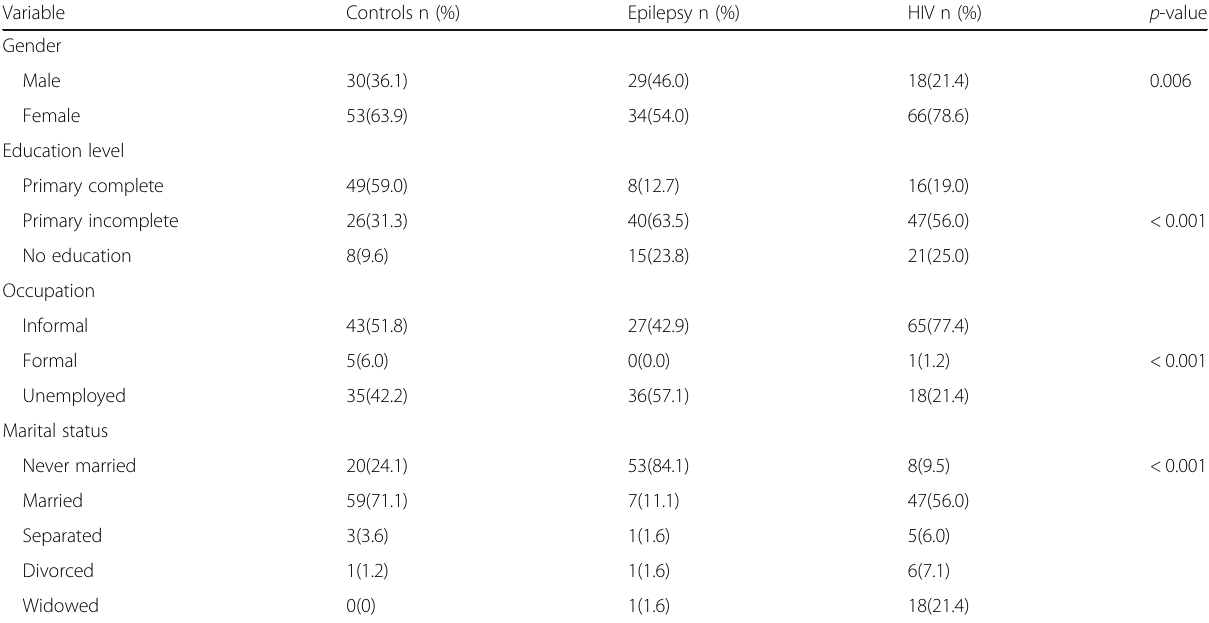
Table 1 Socio-demographic characteristics of the study participants